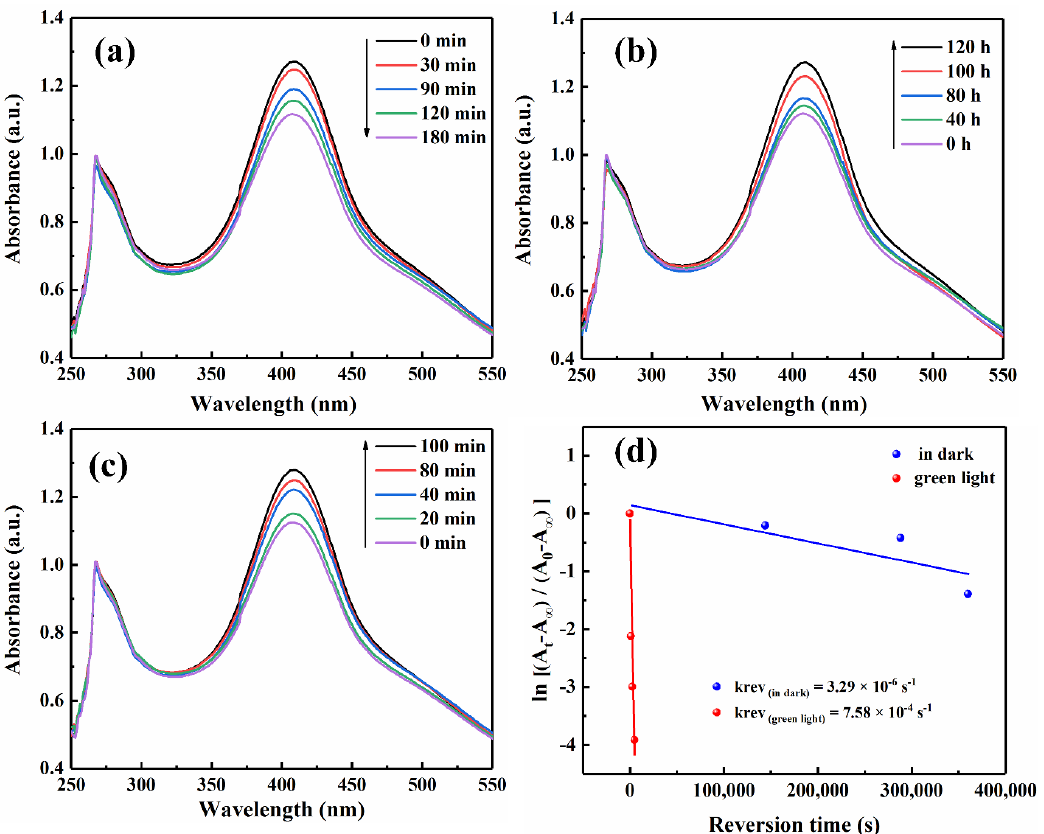
Figure 3. UV–Vis absorption spectra of Azo F -rGO-3 ( a ) under UV irradiation, ( b ) in dark conditions, ( c ) under visible light irradiation, ( d ) reversion rates curves of Azo F -rGO in different environments. Similar to the length of the life cycle, whether the controllable heat release under ex- ternal stimuli can be achieved is critical to the future application value of Azo F -rGO. Fig- ure 3c showed that compared with dark conditions, the irradiation of green light (540 nm) significantly accelerated the recovery process of Azo F -rGO from cis -isomer to trans -iso- mer. Compared with dark conditions, the result that K rev (7.58 × 10 − 4 ·s − 1 ) was significantly larger under green light irradiation also confirmed the conclusion of faster reversion. The same effect can also be achieved by absorbing heat from the external environment accord- ing to DSC. The reason for this phenomenon is that the cis-isomer can absorb energy from external stimuli to overcome the energy barrier of configuration reversion isomerization, thereby achieving the purpose of accelerating energy output [45,46]. The above results show that Azo F -rGO has successfully possessed the controllable heat output capability. The stability of repeated cis ↔ trans configuration transformations of Azo F -rGO and Azo F has also been studied. It can be seen from Figure 4 that both Azo F -rGO and Azo F have no significant decrease in the absorption intensity at 407 nm after repeated irradia- tion of ultraviolet light (365 nm) and visible light (540 nm) for 50 times, which shows that they have outstanding isomerization stability. The Azo F -rGO can not only be stored for a long time under the premise of ensuring the storage effect, but also can control the output of the stored energy, which is essential for actual photothermal conversion.